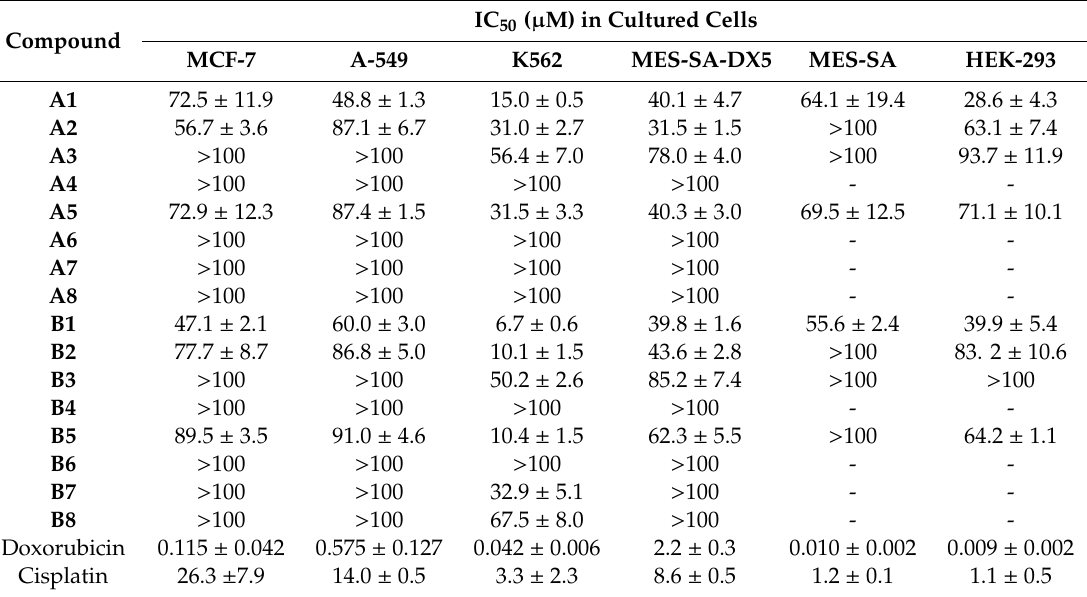
Table 3. Cytotoxic activity of synthetic compounds assessed by the MTT reduction assay.